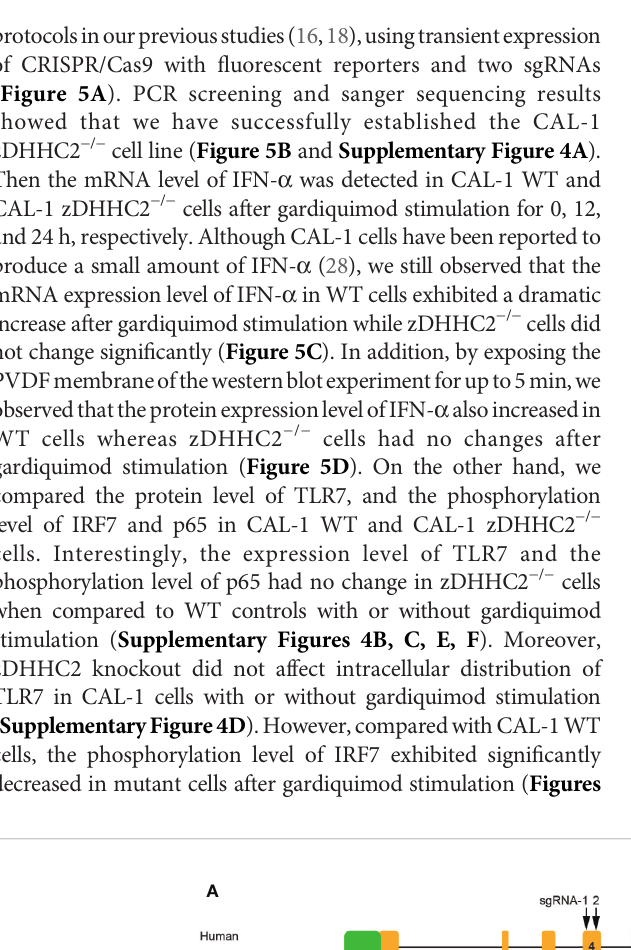
( Figure 5A ). PCR screening and sanger sequencing results showed that we have successfully established the CAL-1 zDHHC2 − / − cell line ( Figure 5B and Supplementary Figure 4A ).